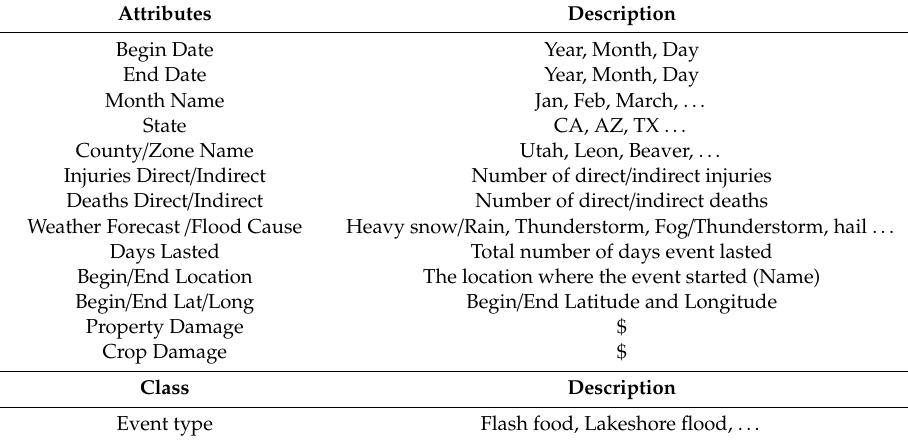
Table 1. Description of the attributes used to build models within the ML based framework to inform flood resilience and resistance actions (Source: NCDC-NOAA [21] and FEMA [20]).